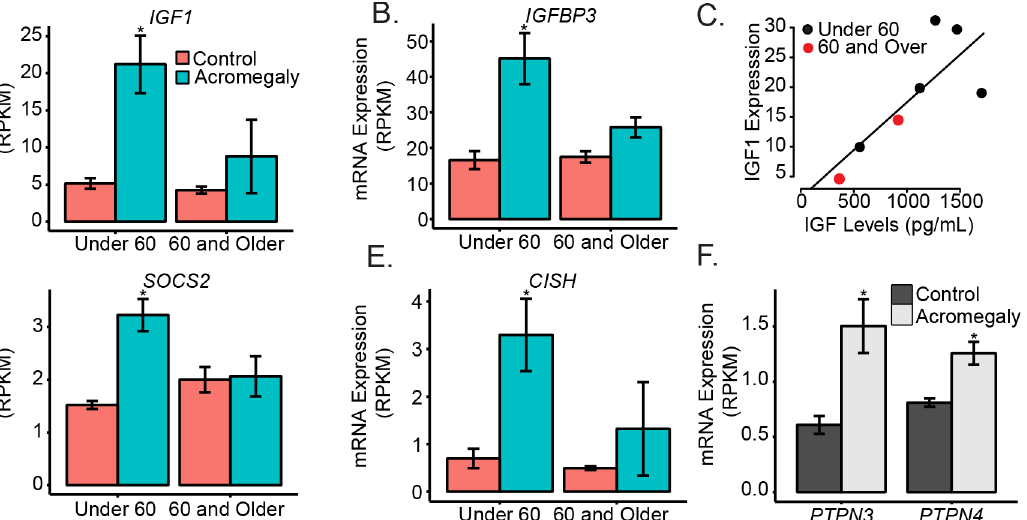
Fig 3. GH targets are differentially expressed in acromegaly subjects. A) mRNA Expression of A) IGF1 and B) IGFBP3 transcript levels in adipose tissue from control and acromegalic patients (C) Comparason between IGF1 mRNA and IGF-1 serum levels in patients with acromegaly (D and E) Expression of mRNA for suppressors of growth hormone signaling (F) and Expression of tyrosine phosphatases associated with growth hormone signaling. Asterisks indicate q < 0.05 for the separated under 60 and 60 or over cohorts for panels A, B, D and E and for the age adjusted combined analysis for panel F. Barplots are presented as mean +/- standard error of the